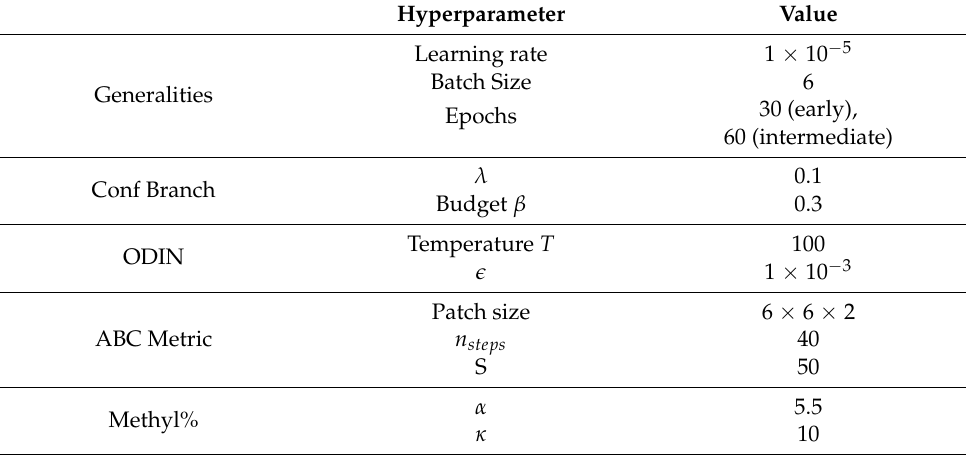
Table A9. Hyperparameters look-up